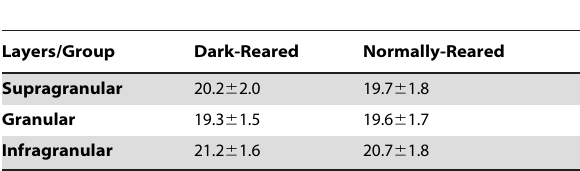
Table 6. Chronic visual deprivation does not affect the numerical densities of ER b -positive cells across cortical layers of